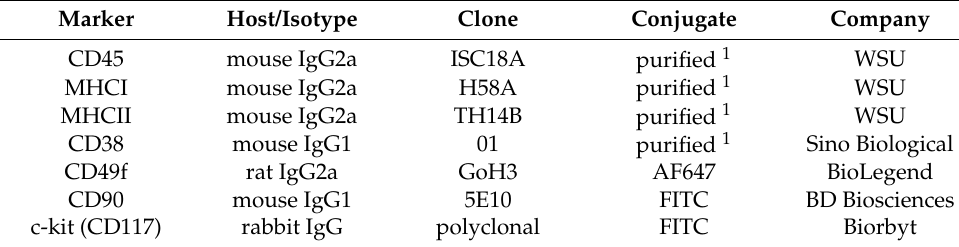
Table 1. List of primary antibodies used for flow